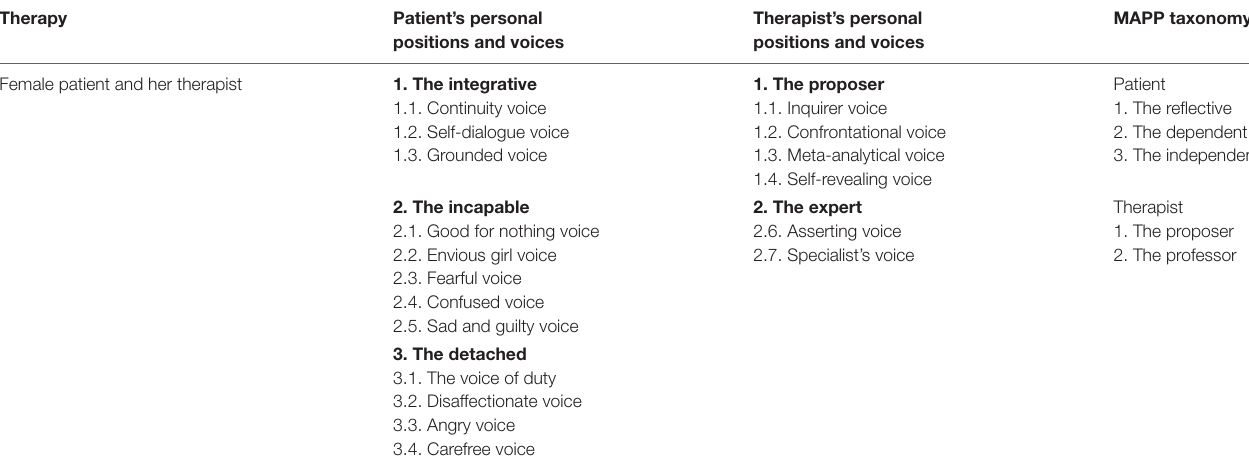
TABLE 3 | Patient’s and her therapist’s voices, personal positions, and MAPP taxonomy.